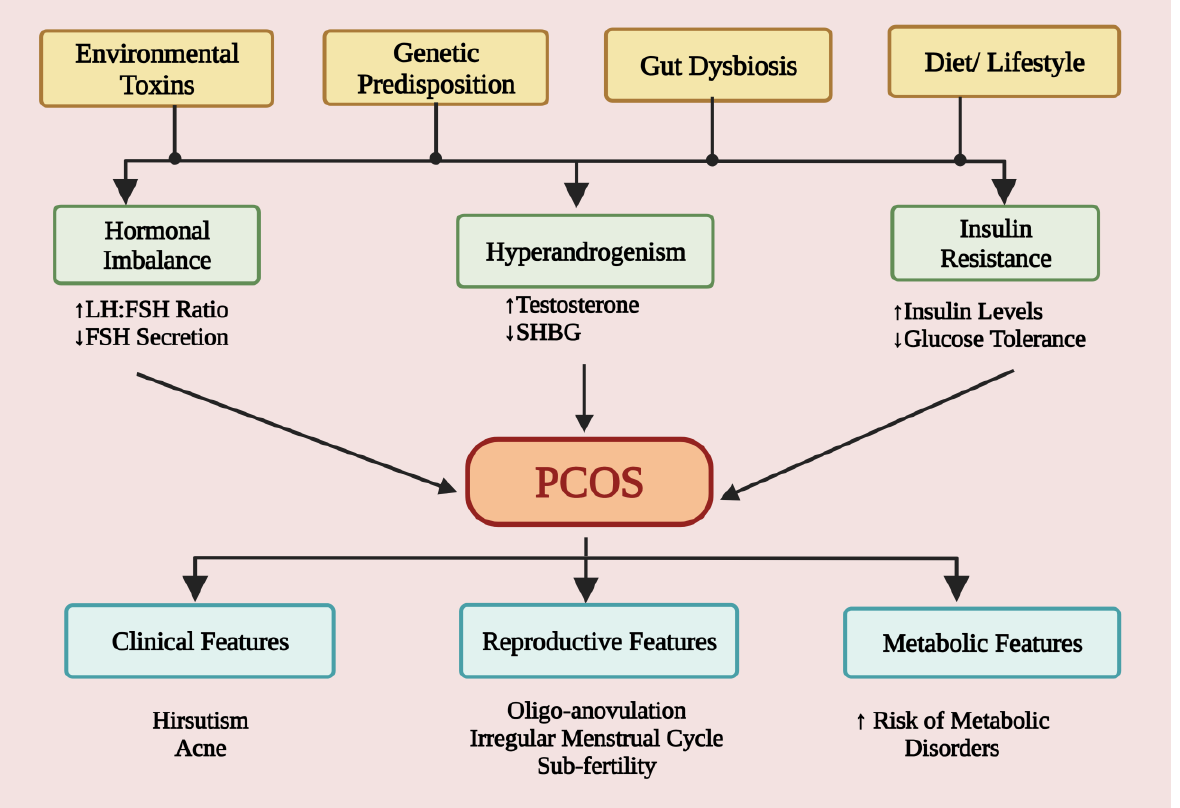
Figure 1. This schematic illustration shows the proposed pathophysiology and features of PCOS. The risk factors like environmental toxins, genetics, gut dysbiosis, and diet responsible for the pathophysiology of the PCOS and subsequent development of clinical, reproductive and metabolic features in PCOS patients. LH: luteinizing hormone; FSH: Follicle stimulating hormone; SHBG: Sex hormone binding globulin .